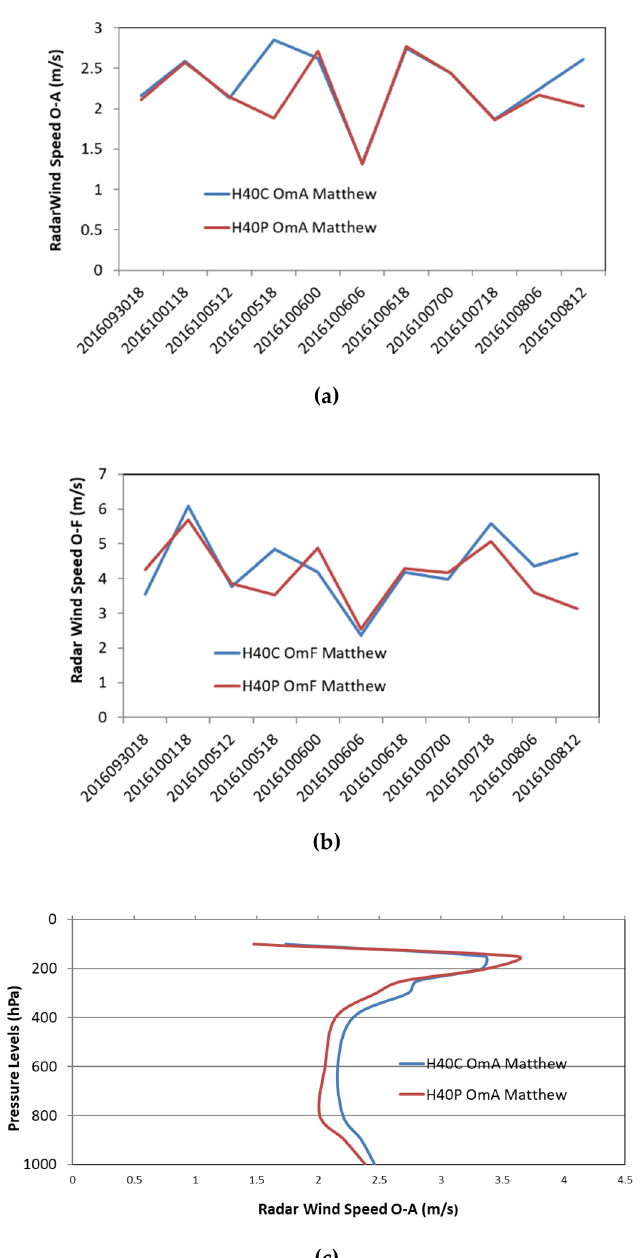
Figure 7. Comparisons between the H40C (blue) and the H40P (red) of ( a ) the TDR radial velocity OmF, ( b ) the TDR radial velocity OmA, and ( c ) the TDR radial velocity average of observation minus Analysis (OmA) vertical profiles, for Hurricane Matthew, 2016.